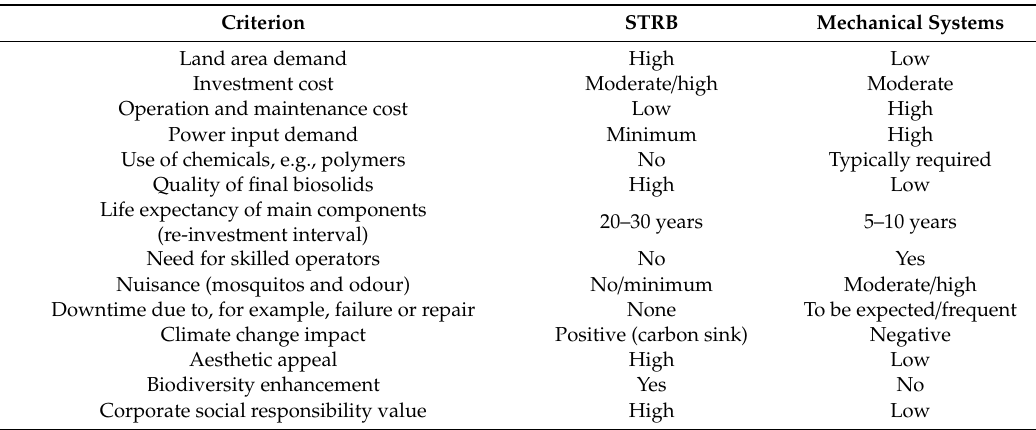
Table 6. Overall evaluation of STRB and mechanical methods for industrial sludge dewatering.